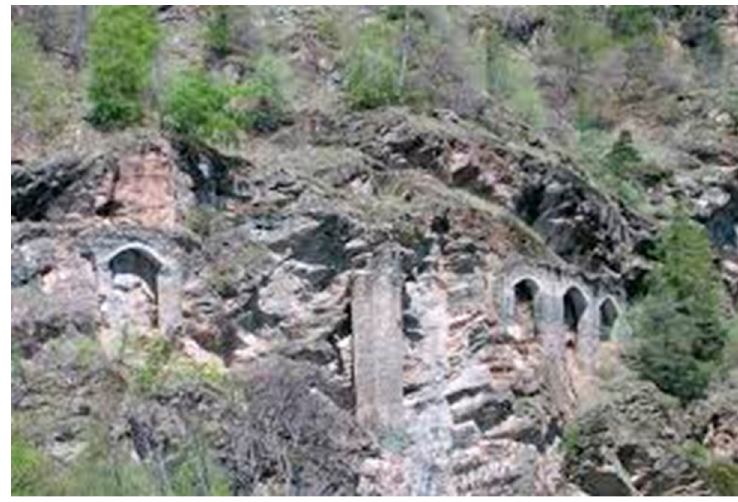
Figure 9. The Pan Perdu Ru: the “wasted bread canal”.